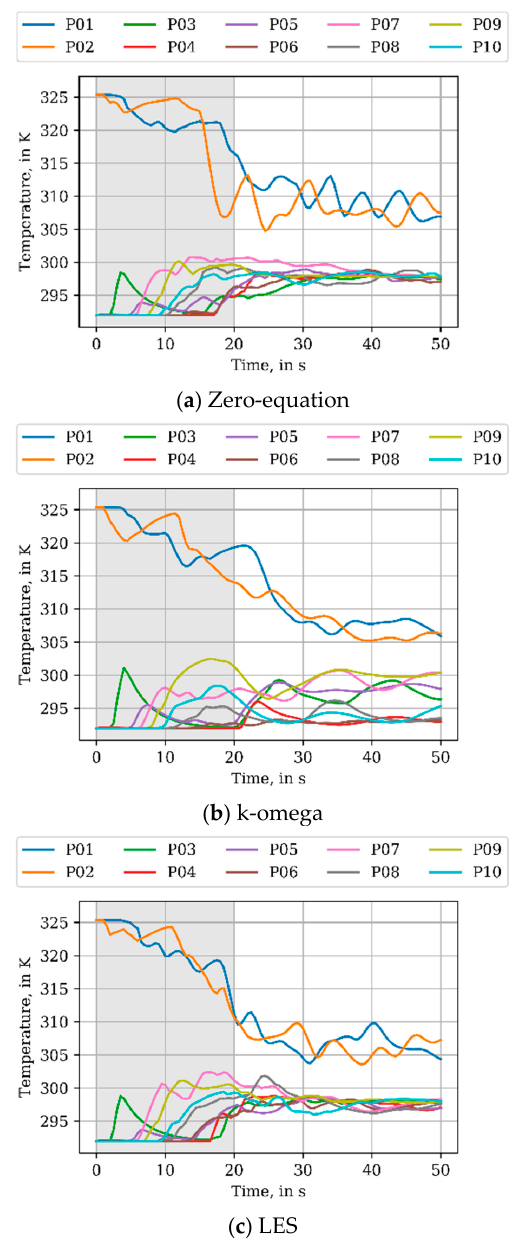
Figure 9. Temperatures for each set of numerical probes for the turbulence models: ( a ) zero-equation, ( b ) k-omega, and ( c ) LES.